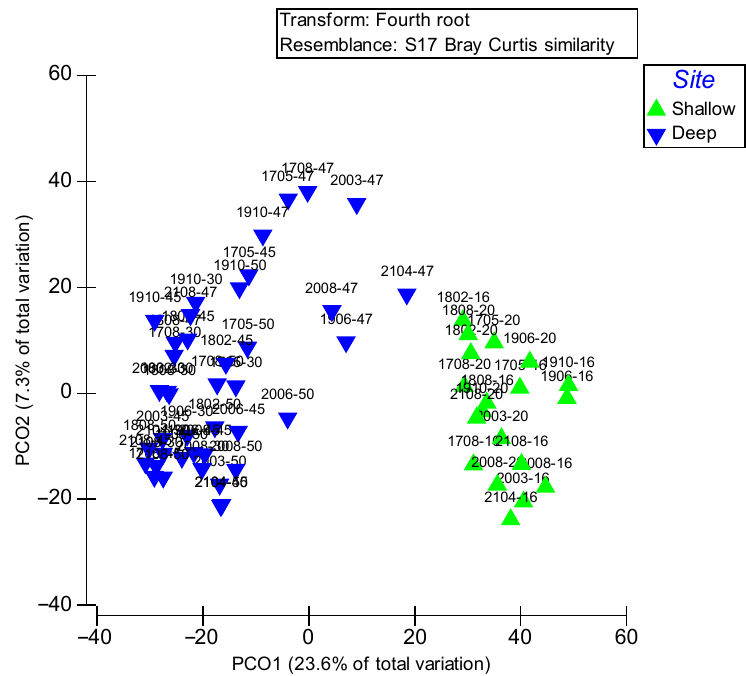
Figure 4. Principal components analysis (PCO) of macrobenthos.